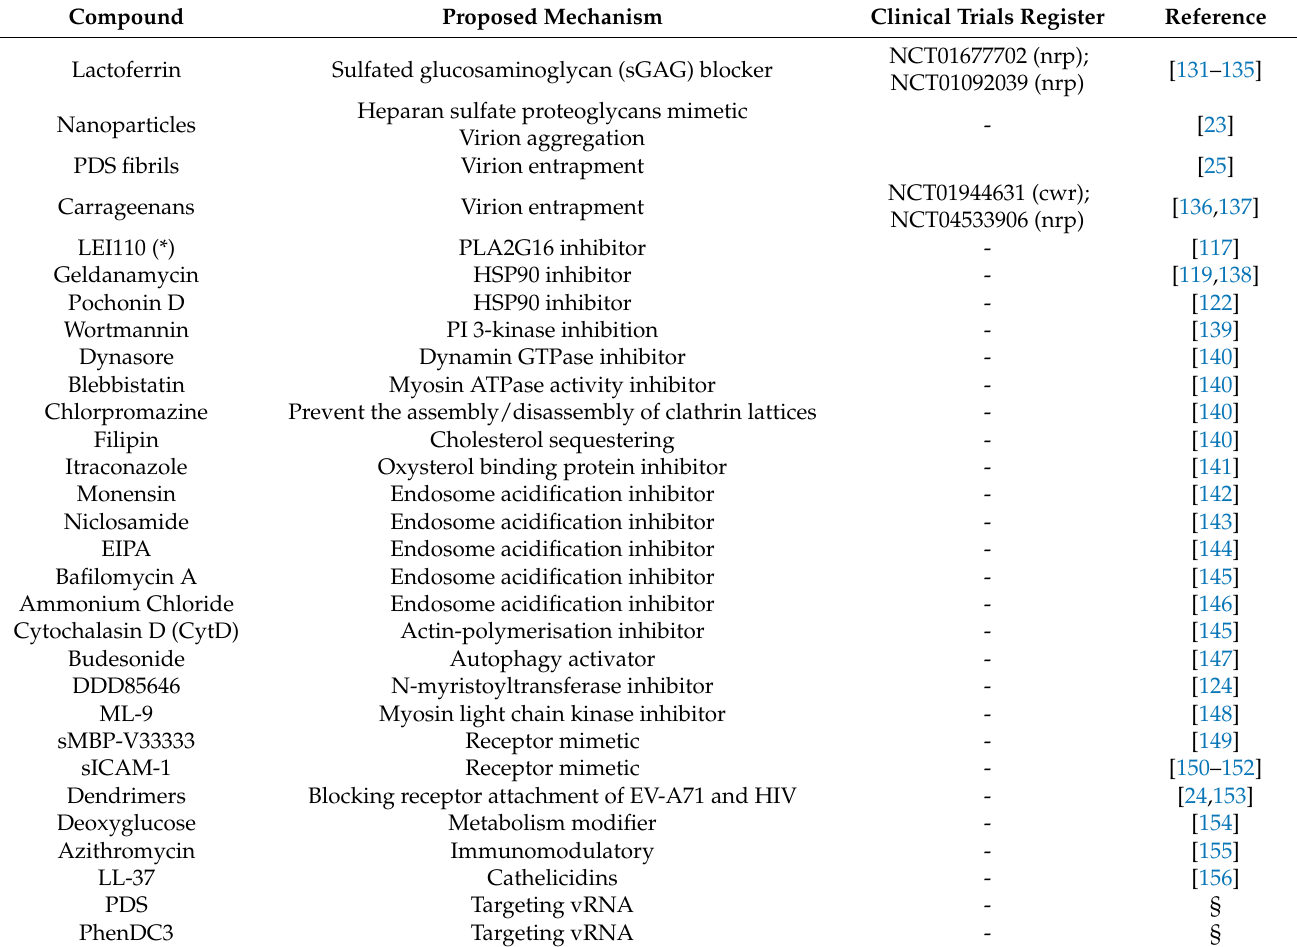
Table 3. List of compounds targeting non-viral proteins and proposed mechanism of